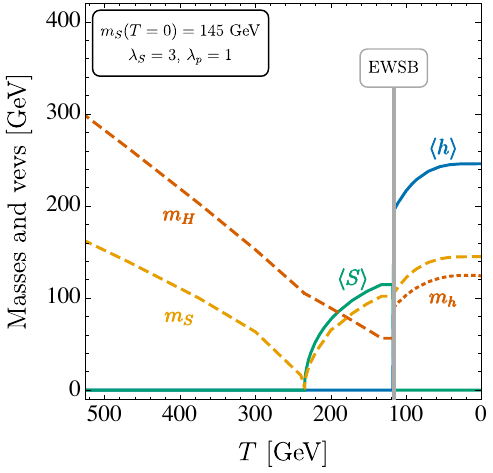
Figure 3 . Evolution of the scalar vevs and masses with temperature for a particular parameter point. m H denotes the mass of the SM Higgs doublet above electroweak symmetry breaking, while m h is the mass of the SM-like physical Higgs boson below. The interaction between the SM Higgs and the new scalar, S , has reduced the EWSB temperature from its usual value around 160 GeV to 116 GeV.